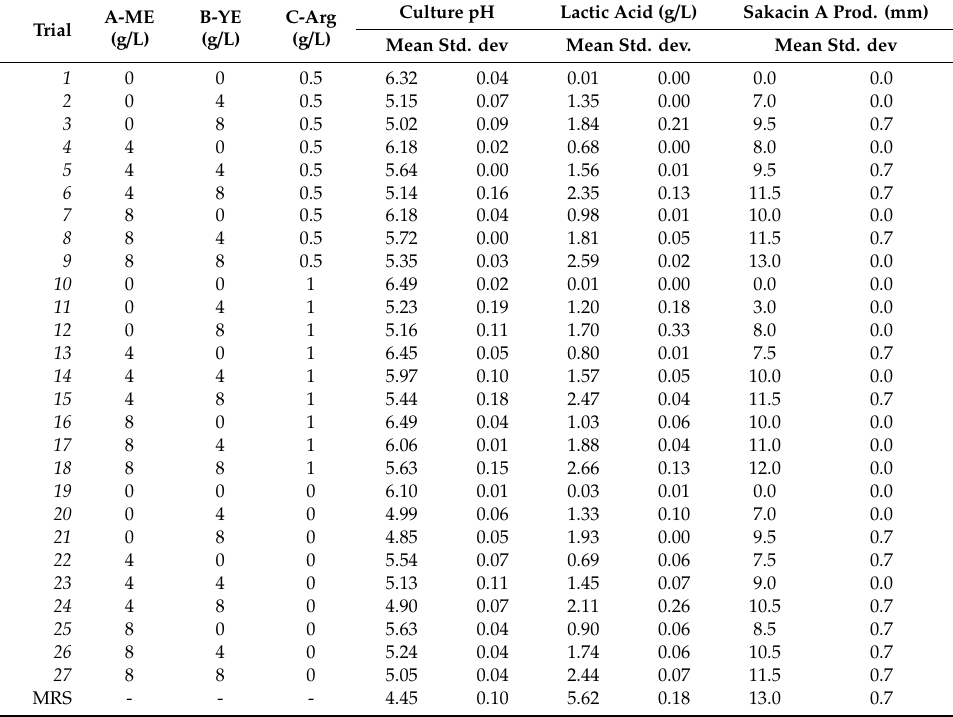
Table 3. Arrangement of the experimental design performed with L. sakei grown at 26 ◦ C for 16 h (ME-Meat Extract, YE-Yeast Extract, Arg-arginine) and observed responses: Culture pH, lactic acid concentration (g / L) and sakacin A production (expressed as inhibition halo-mm-vs. L. innocua ). Culture pH Lactic Acid (g / L) Sakacin A Prod. (mm) A-ME B-YE C-Arg Trial (g / L) (g / L) (g / L) Mean Std. dev Mean Std. dev. Mean Std.